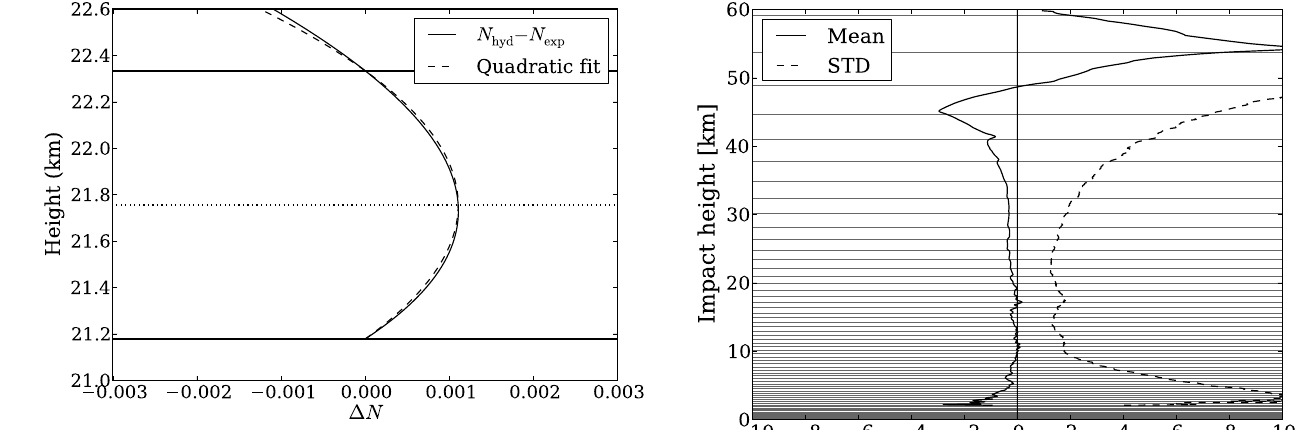
Figure 6. The difference of the corrected hydrostatic refractivity and the exponentially varying refractivity between a single pair of Met Office model levels (horizontal lines). Also shown is a quadratic approximation to this difference, as described in the text. The horizontal dotted line shows the midpoint of the layer where the quadratic correction is set to be equal to the difference of the hydrostatic and exponential values.